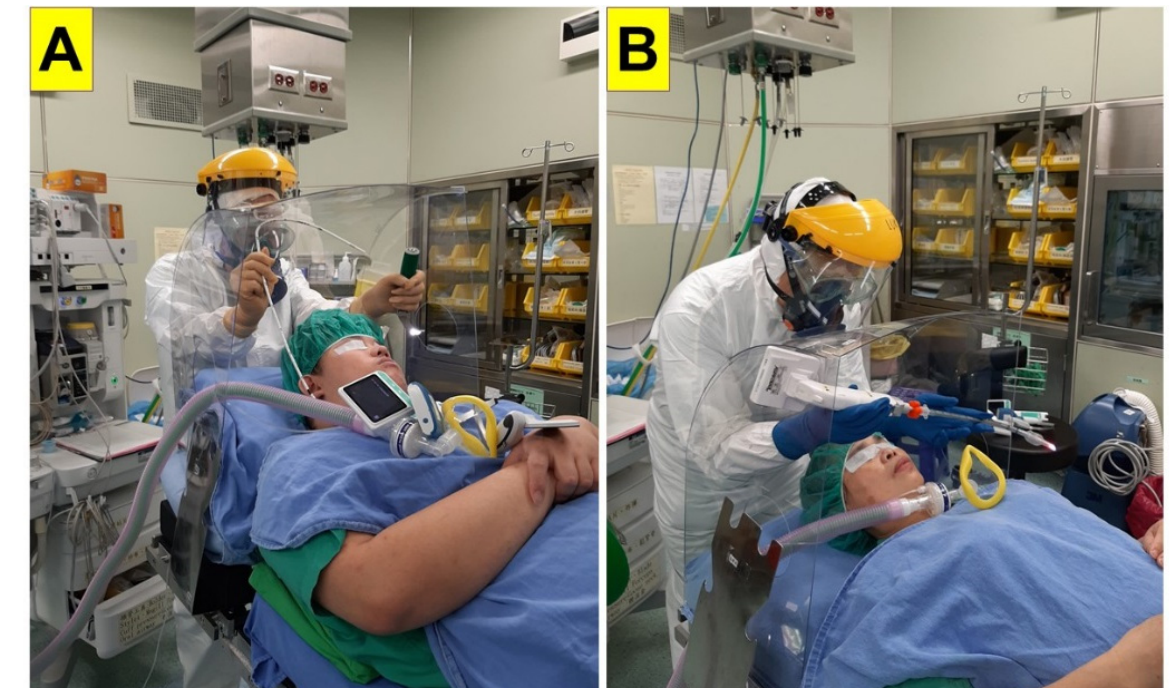
Figure 8. The plastic barrier box seriously limits the ability to perform endotracheal intubation utilizing: ( A ) the video- laryngoscope or conventional direct laryngoscope and bougie; a BMI-38 model in a ramp position; and ( B ) the video intubating stylet; a BMI-24 model in a neutral supine position. BMI: body mass index.